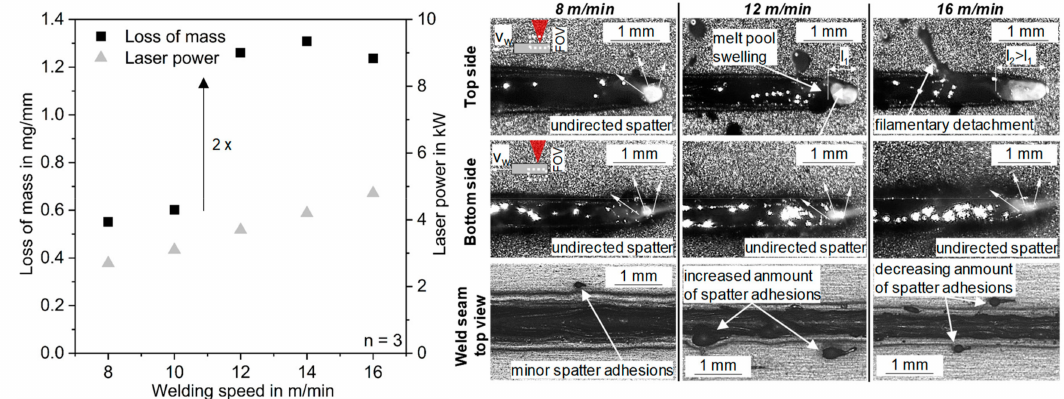
Figure 2. Loss of mass and melt pool dynamics of the reference process as function of welding